Question: Reading the figure, is the described quantity rising or falling?
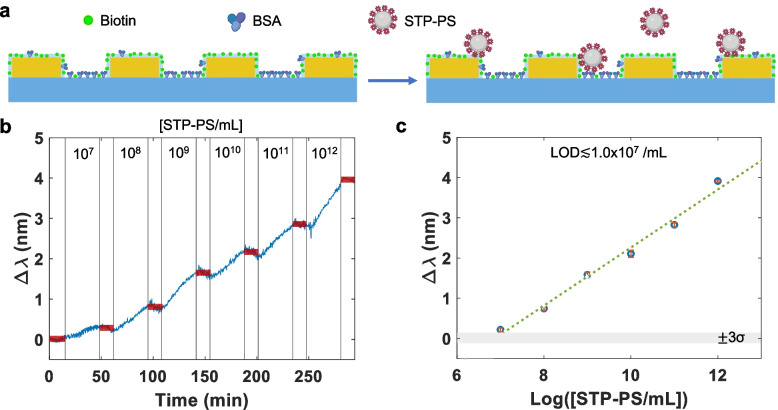
Answer: increasing